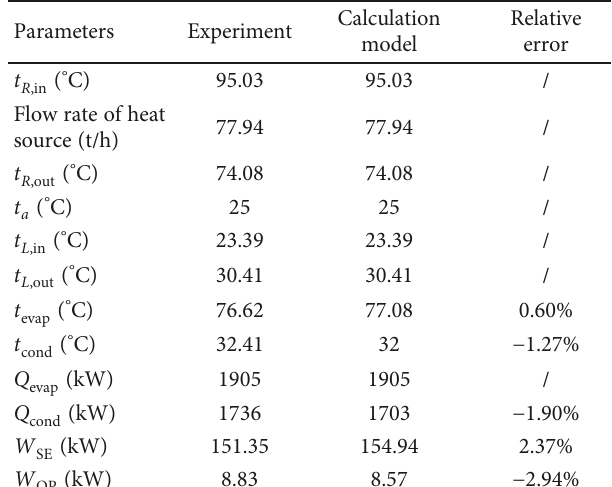
Table 3: Comparison of the calculation model and the experiment.